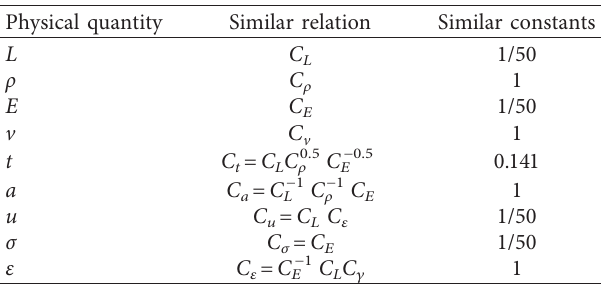
Table 3: The similar constants.